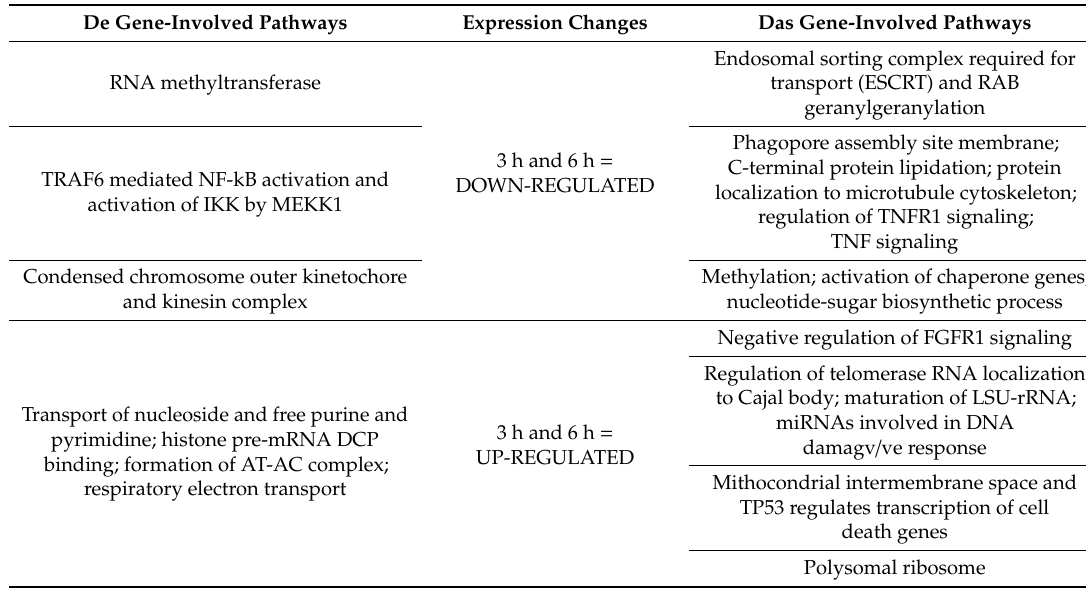
Table 2. Detailed analysis of DE and DAS gene-involved pathways, with their possible impact on retinal dystrophies etiopathogenesis. DE and DAS genes were dysregulated during the whole analysis and showed several fluctuations during observed time points, suggesting that changes in gene-level expression and alternative splicing occurred throughout the whole period, either transiently (occurring after 3 h and returning to initial level after 6 h), occurring later (only after 6 h from treatment) or enduring throughout the whole